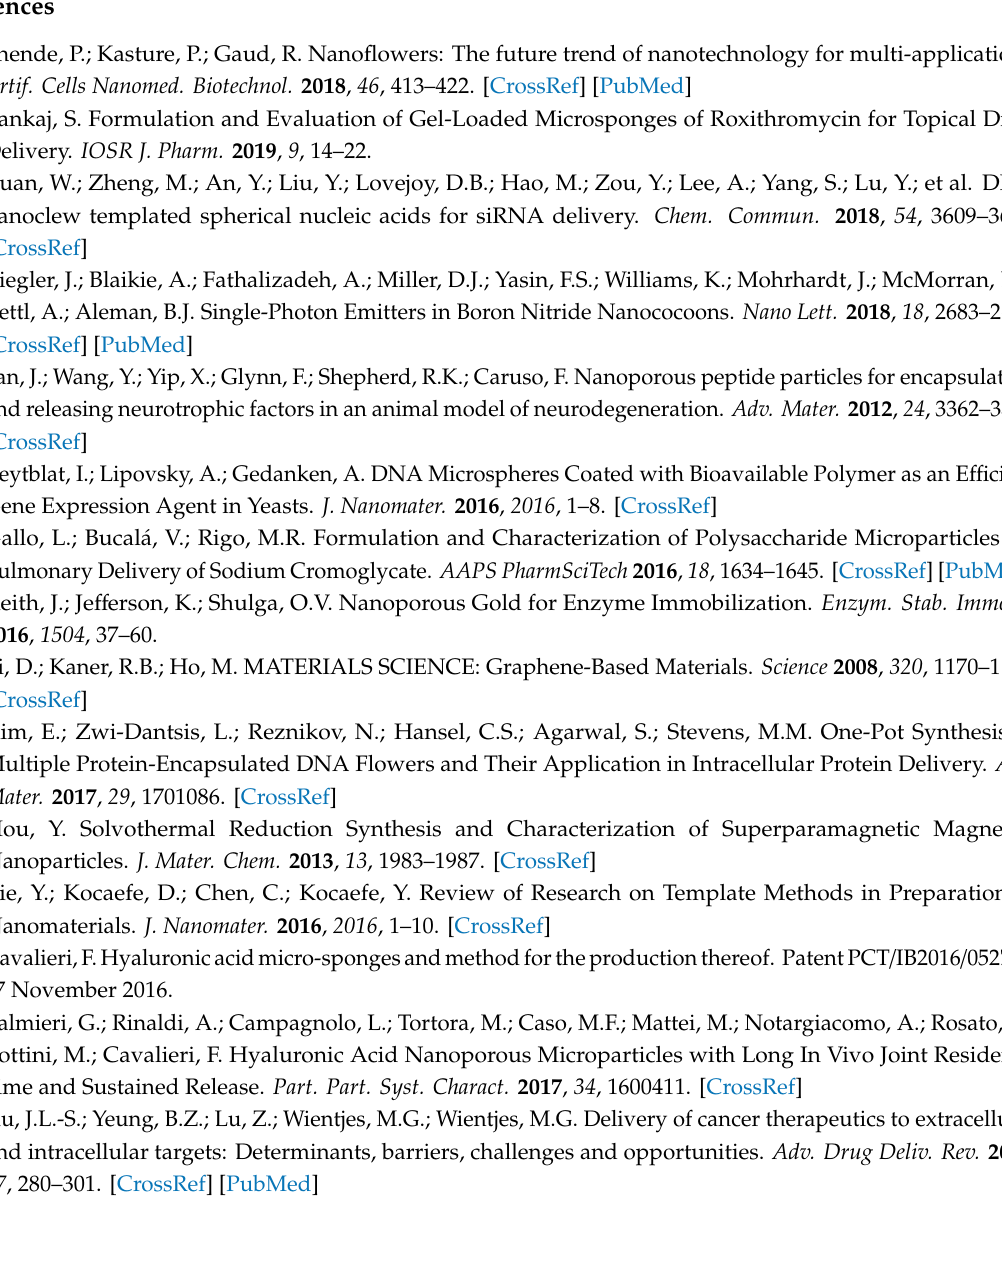
Figure S1–S4: NMR Spectra, Figure S5: DTT accelerated NMP degradation, Table S1: DMSO-Particles degradation by DTT, Table S2: H 2 O-Particles degradation by